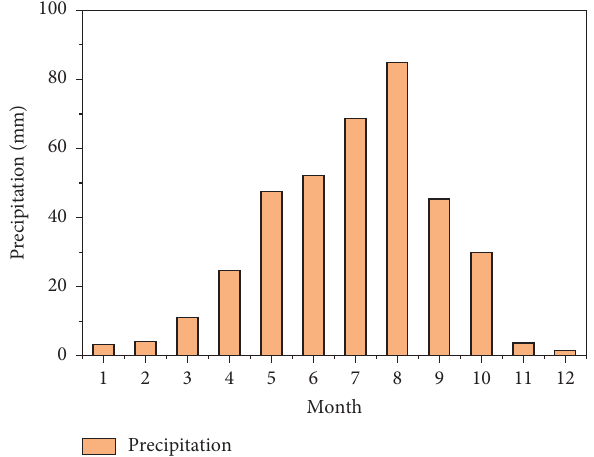
Figure 6: Distribution of monthly average precipitation in the study area from 1981 to